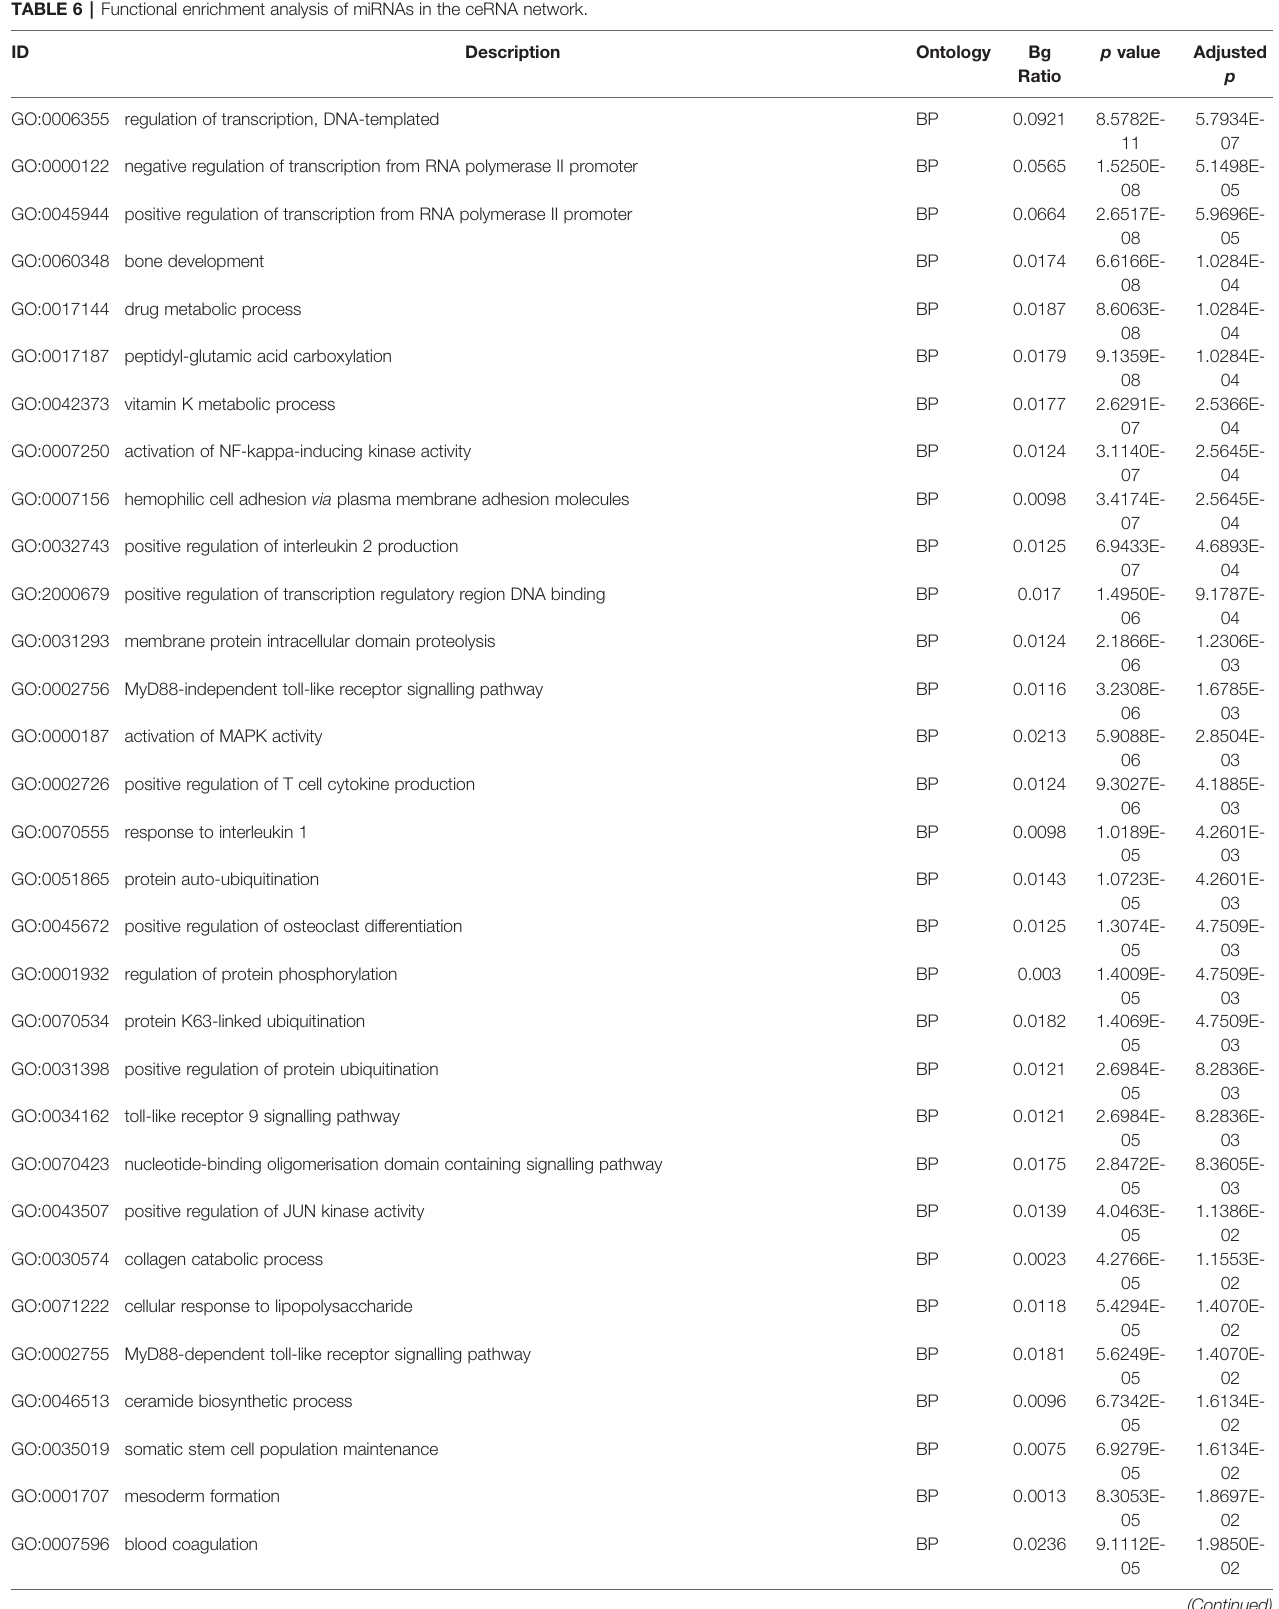
TABLE 6 | Functional enrichment analysis of miRNAs in the ceRNA